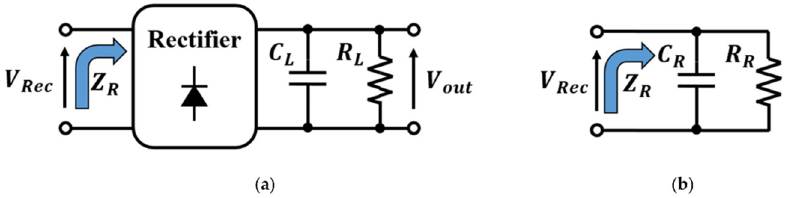
Figure 5. ( a ) Circuit of rectifier and load and ( b ) linearized model. The input impedance of the rectifier can be determined by running a circuit sim- ulator such as SPICE. An equivalent circuit model for the rectifier followed by the load can be expressed by a parallel circuit of and , as shown in Figure 5b, because the imaginary part of the input impedance of Figure 5a is negative. The values of and can be calculated from the waveforms of the input voltage , the input current and the power into the rectifier when is as high as the specified value at the target as follows. Figure 6 shows the waveforms simulated with SPICE. The rectenna circuit was composed of voltage doubler (VD) described later as a rectifier, ESD protection diodes, of 0.3 and of 8 at 920 , = 100 and = 1 . Blue and orange dashed lines mean peak voltage of and average power of , re- spectively.